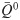
Stability of ongoing learning for both afferent and recurrent connectivities.A: Network configuration with m = 20 inputs and n = 5 outputs. Each input pattern corresponds to a randomly chosen m × m matrix W with 10% density of non-zero connections that determines the input covariance matrices (P0, P1) of the time series generated from Eq 13. The objective Q¯0 is a randomly-drawn m × m symmetric matrix (also ensuring its definite positivity). Here we consider a single category (in red) to test whether the weight learning rule can achieve a desired input-output mapping, leaving aside classification for a moment. B: Example evolution of the afferent and recurrent weights (green and purple traces, respectively). Simulation of the time series as in Fig 5, observed for a duration d = 50. The network has to map 10 input pattern pairs (P0, P1) similar to the example in panel A to a single output Q¯0. C: Evolution of the tuning of the network output. The learning procedure aims to reduce the normalized error between the output covariance Q0 and its objective Q¯0 (left plot, similar to Fig 3F), here calculated as ∥Q¯0-Q0∥/∥Q¯0∥ where ∥⋯∥ is the matrix norm. We also compute the Pearson correlation coefficient between the vectorized matrices Q0 and Q¯0 (right plot). The thick black traces correspond to the mean over 10 repetitions of similar optimizations to panel A, each gray curve corresponding to a repetition. D-E: Similar plots to panels A-B for the tuning of both (Q¯0,Q¯1) for a single repetition. The input time series are generated in the same manner as before. Contrary to panel A, the output objective pair (Q¯0,Q¯1) is chosen as two homogeneous diagonal matrices with larger values for Q¯0 than Q¯1, corresponding to outputs with autocorrelation and no cross-correlation —this example is inspired by previous work on whitening input signals [40]. The observation duration is d = 100.